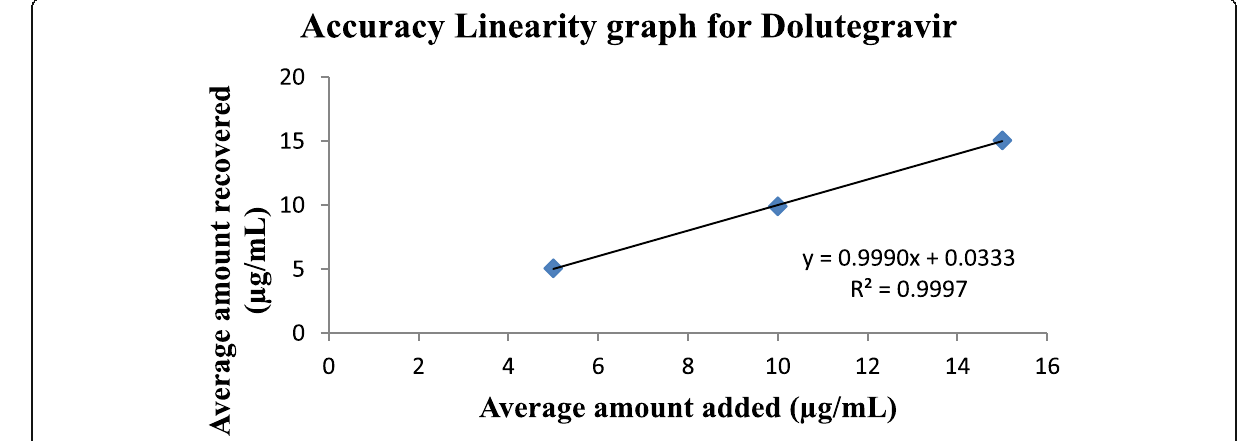
Fig. 9 Accuracy linearity of dolutegravir